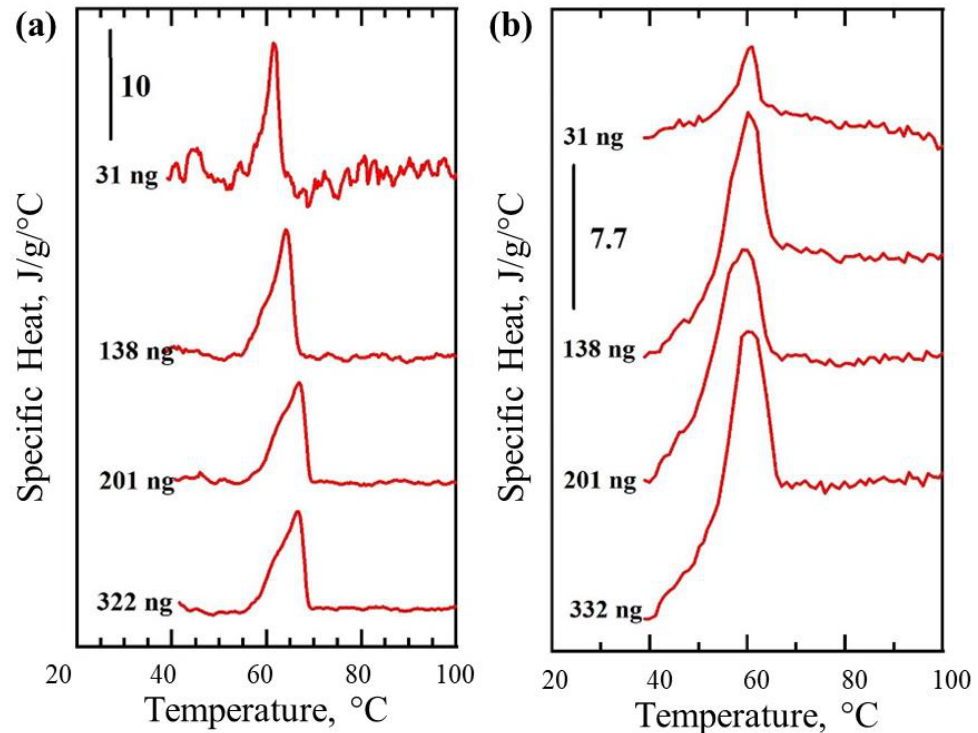
Figure 6. Specific heat changes during melting of polyethylene glycol (PEG) determined using thermal nano-analyzer instrument in DC and AC/DC modes. Specific heat vs. sample temperature derived from heat flow recorded in DC mode ( a ). All graphs are shown to the same scale in ( a ). Specific heat changes during PEG melting, estimated from the recorded profile of heat modulation AC amplitude. Calibration is done using PEG heat of fusion value measured in DC mode ( b ). That should allow quantitative estimates of the changes (fold difference) to the ob- served specific heat c . We therefore expressed the AC thermograms in terms of heat capacity (Figure 6b) which yielded profiles, with the melting peaks appearing nearly identical to the traditionally calculated specific heat (Figure 6a) and the areas under the peaks being proportional the T mod changes recorded (Figure 6b). This experiment proves that AC com- ponent provides an alternative way to quantify the samples or phase transitions observed. However, unlike the DC mode, the AC sensing is characterized by the limited AC pene- tration depth, which should allow localized thermal analysis. If the thermal penetration depth is small compared to the critical dimensions of the sample, the determined value of the heat capacity will reflect the heat capacity of the part of the sample being sensed, not the entire sample (Supplementary Figure